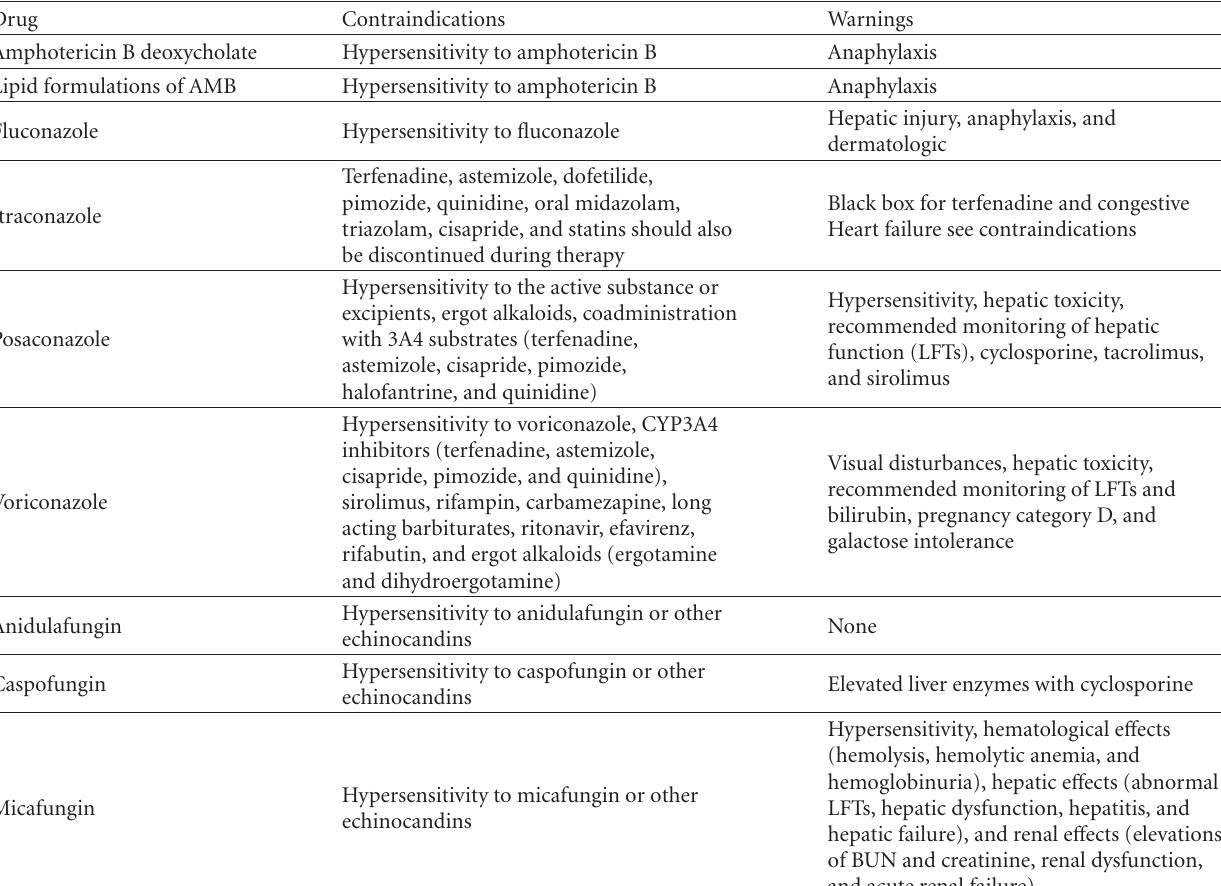
Table 4: Current contraindications and FDA warnings for each antifungal agent available.